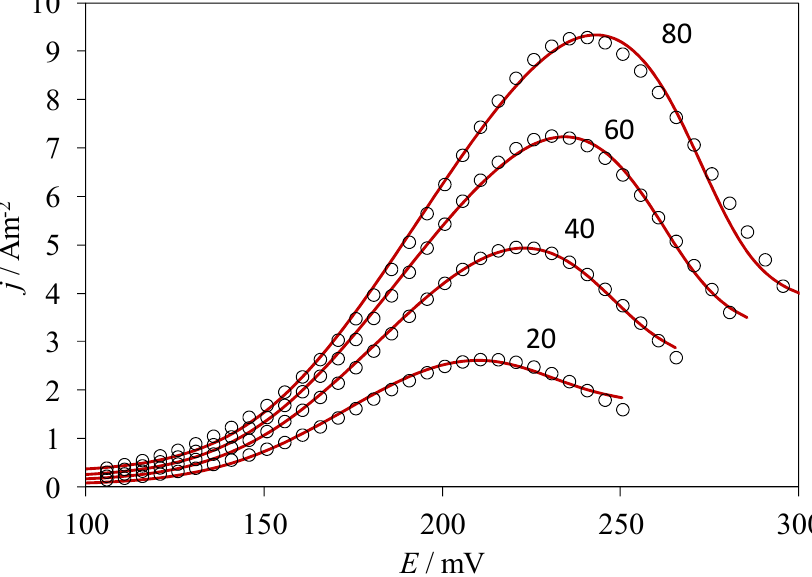
Figure 5. Comparison of the experimental CVs from the system CPE/poly- β -CD/1 mM AA, 0.1 M NaCl, at pH 3.0 (points) and theoretical plots (lines) generated through linear non-linear fitting of Equation (1), at different potential scan rates as indicated, in mV s − 1